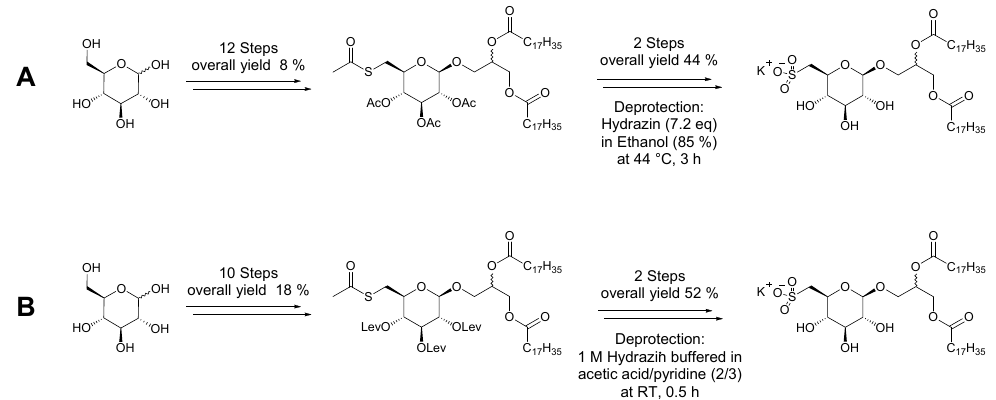
Scheme 3. Comparison of the main differences between the synthesis route of ( A ) Manzo et al. (2017) [13] and ( B ) the new route of the present work.